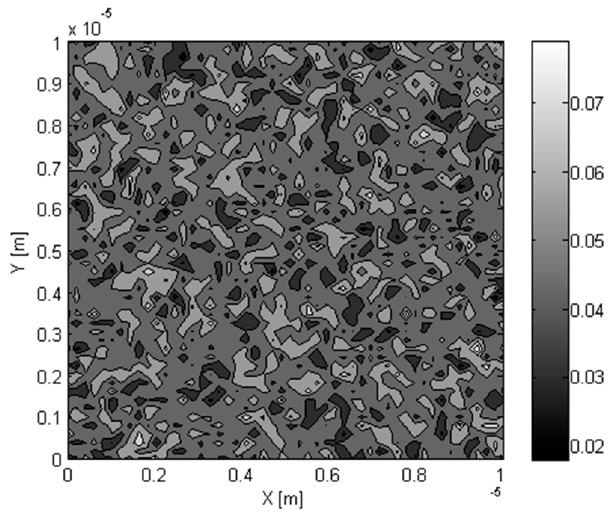
Figure 6. Distribution of Si nanoparticle volume fraction in Ge matrix.